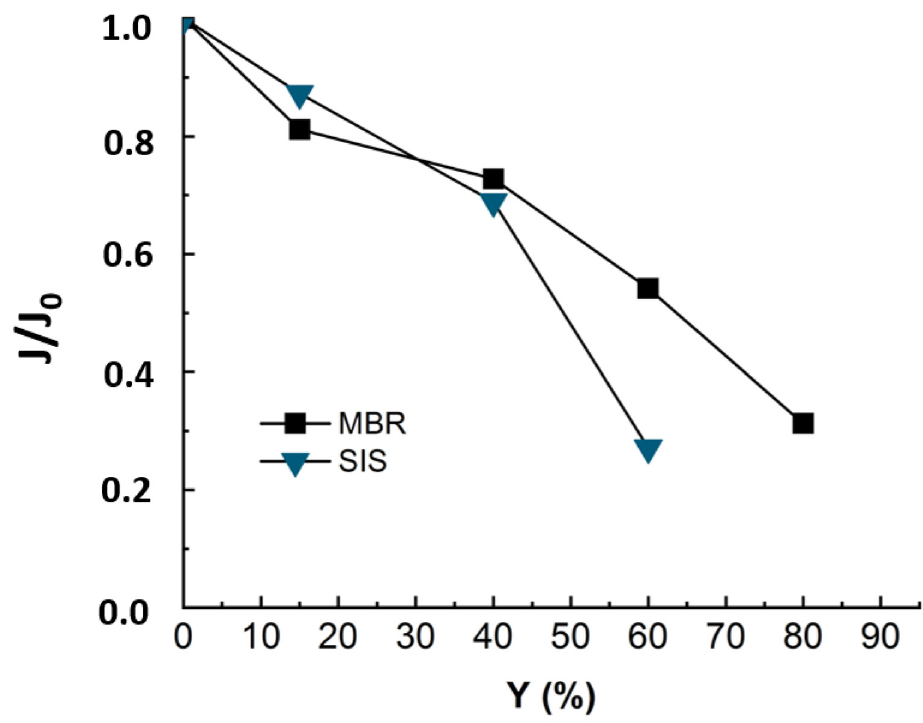
Figure 4. Flux evolution during NF experiment applied to MBR real effluent (duration of the experiment = 24 h) and synthetic ionic solution matrixes SIS (duration of the experiment = 18 h). TMP = 10 bars, T ◦ = 20 ◦ C, J 0 -SIS = 64 L · m − 2 · h − 1 , J 0 -MBR = 53 L · m − 2 · h − 1